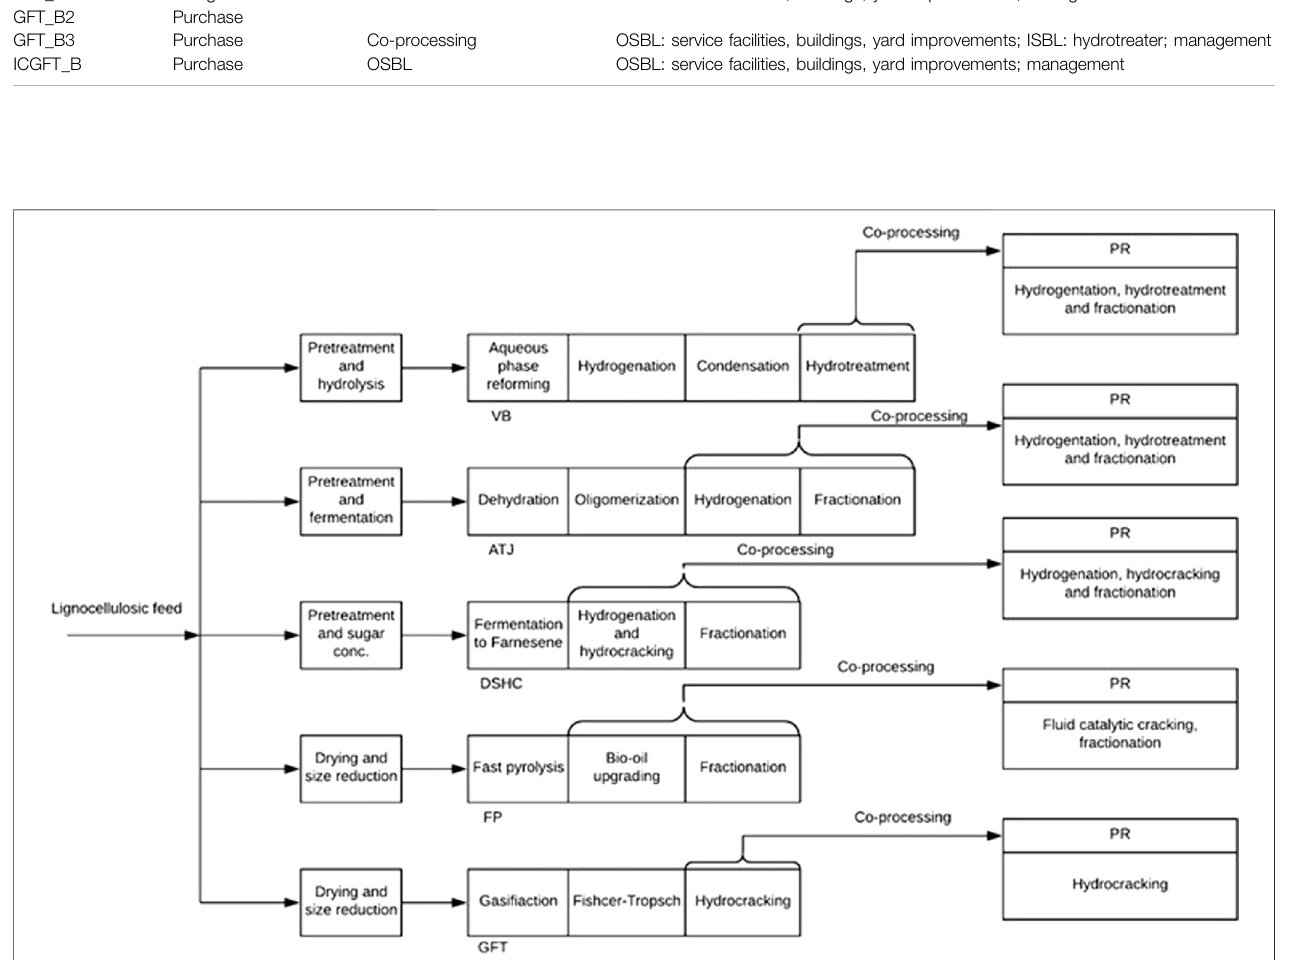
Frontiers in Energy Research |